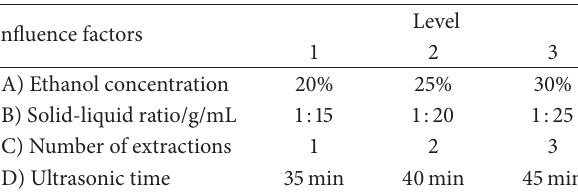
Table 2: Factors and levels of the orthogonal design. Influence factors